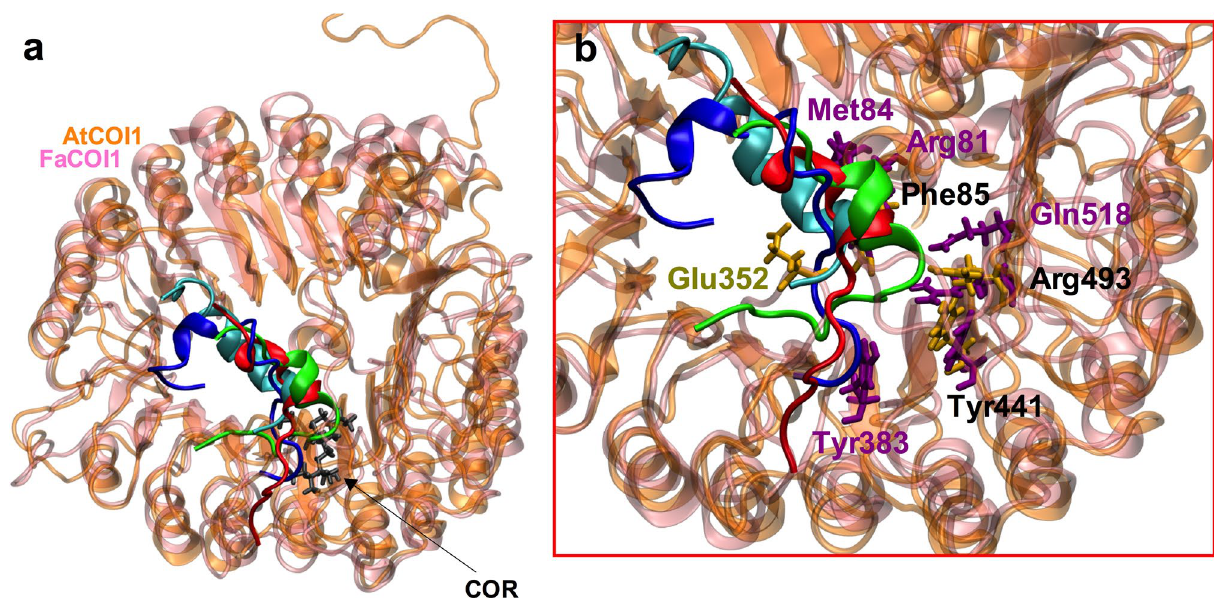
Figure 7. Structural superposition of the FaCOI1 and AtCOI1 after the interaction with FaJAZ1, FaJAZ10, and AtJAZ1. A representative view of the structural superposition of the four protein–ligand–protein complexes ( a ). A closer view of the FaCOI1 and AtCOI1 interaction cavity when FaJAZ1 (in blue), FaJAZ10 (in red or green), and AtJAZ1 (in cyan) are oriented in the presence of COR as a ligand in the interaction complexes ( b ). In ( b ), the main residues involved in the interaction of the AtCOI1 and FaCOI1 are showed: in yellow the residue that interacts only in the AtCOI1 with FaJAZ10 (in green) or AtJAZ1, in magenta the residues that interact only in the FaCOI1 with FaJAZ1 or FaJAZ10 (in red), and in black the residues that interact in the four complexes formed. Only for better visualization of the residues involved in the interaction, the COR ligand was removed from view in ( b ). NewCartoon representations were obtained with VMD software. At, Arabidopsis thaliana ; Fa, Fragaria × ananassa ; COI1, CORONATINE INSENSITIVE1; JAZ, JASMONATE-ZIM DOMAIN; COR,